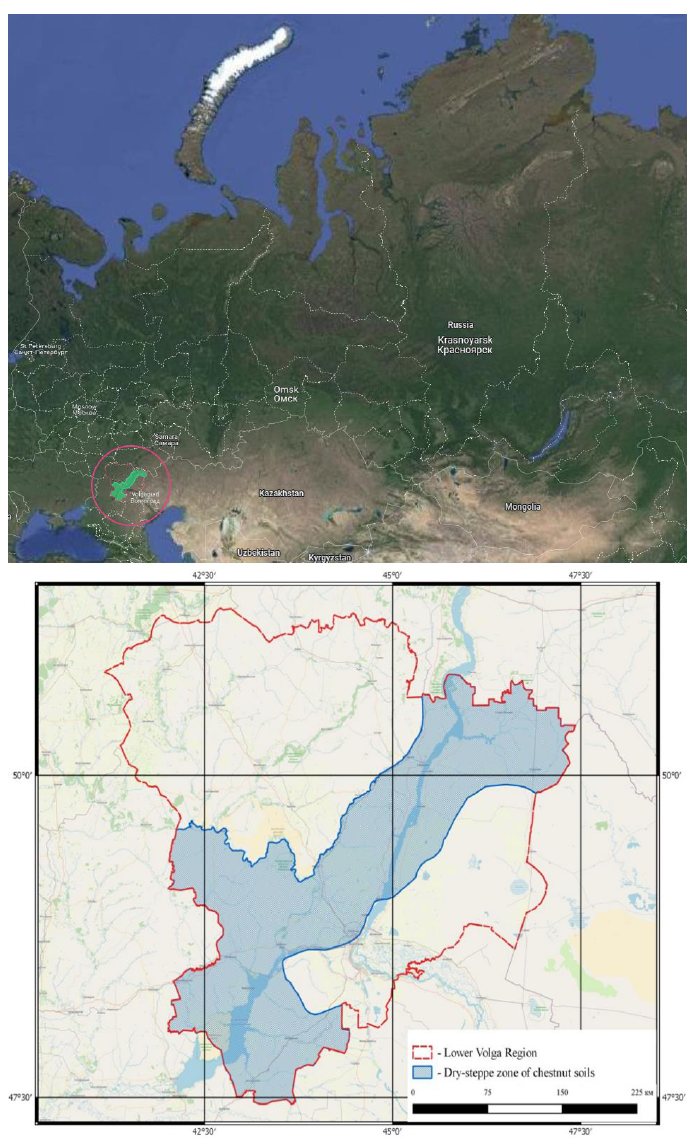
Figure 1. Geographical location of the dry-steppe zone of chestnut soils. Humus in typical chestnut soils noticeably decreases from the northeast to the south- west of the dry-steppe zone; therefore, it is most often observed in chestnut soils of the Volga upland (2.4%) and least of all in soils of the Ergeny upland (2.2%). The content of gross forms of nitrogen (N) is 0.2% and 0.15%, respectively; phosphorus (P 2 O 5 )–0.05% and 0.09%; potassium (K 2 O)–1.7% for all geomorphological areas [15]. The climate of the dry-steppe zone is very continental (the coefficient of continence is 209–224). This is manifested in moderately cold and snowless winters, as well as warm and very dry summers. The sum of active temperatures is 2500–3100 ◦ C. The peculiarity of the zone is the discrepancy between the amount of annual precipitation and possible evaporation. Thus, the annual precipitation is 255–443 mm, and the evaporation rate is about 2–3 times greater. According to the annual moisture content, the dry-steppe zone belongs to a very arid and semi-dry zone. The moisture coefficient is 0.26–0.48 [16]. The 5-year dynamics (2016–2020) of the main climatic indicators, obtained on the basis of data from reference weather stations of the dry-steppe zone, indicates a high continentality of the climate of the studied region, increasing from the north-east to the south-west (Figure